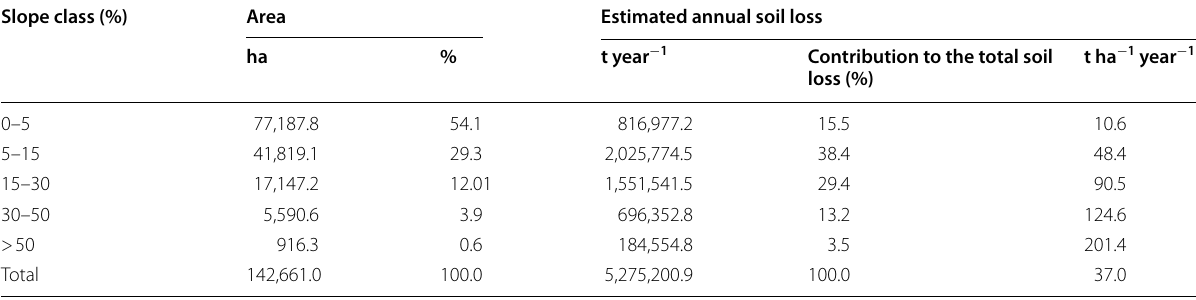
Table 5 Variation of annual soil erosion rates with slope